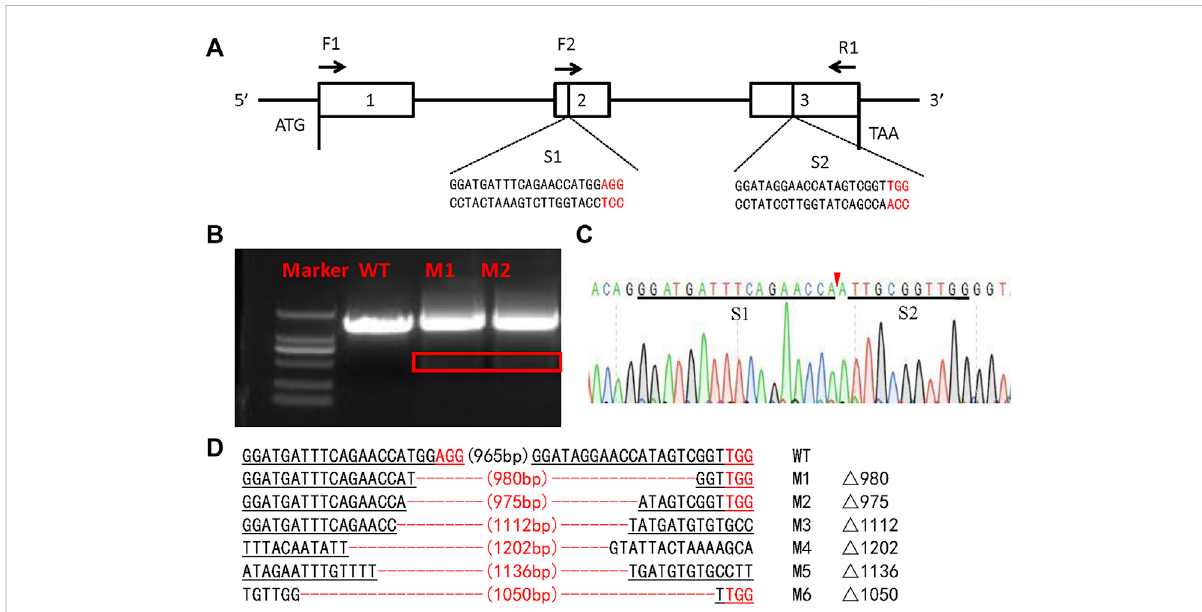
FIGURE 2 Theschematicof SlSer2 targetsitesandCRISPR/Cas9mediatedmutations. (A) Genomicstructureofthe Ser2 genein Spodopteralitura ( SlSer2 ). The sgRNA targeting sequences (S1 and S2) are in black text and the protospacer adjacent motif (PAM) sequences are in red. The approximate locationsofampli fi cationprimers(F2andR1). (B) AgarosegelelectrophoresisofPCRproductsusedforinitialdetectionofthemutationsinthe SlSer2 gene. The red box represents the deleted sequence fragment of SlSer2 mutants. (C) Sequencing chromatogram of SlSer2 mutants. The black linerepresentsthetargetedregion.TheredwedgeindicatespositionofcleavagebyCRISPR/Cas9genomeeditingsystem. (D) Mutationsdetectedby sequencing. The PAM sequence is in red. The black line represents the target sites.